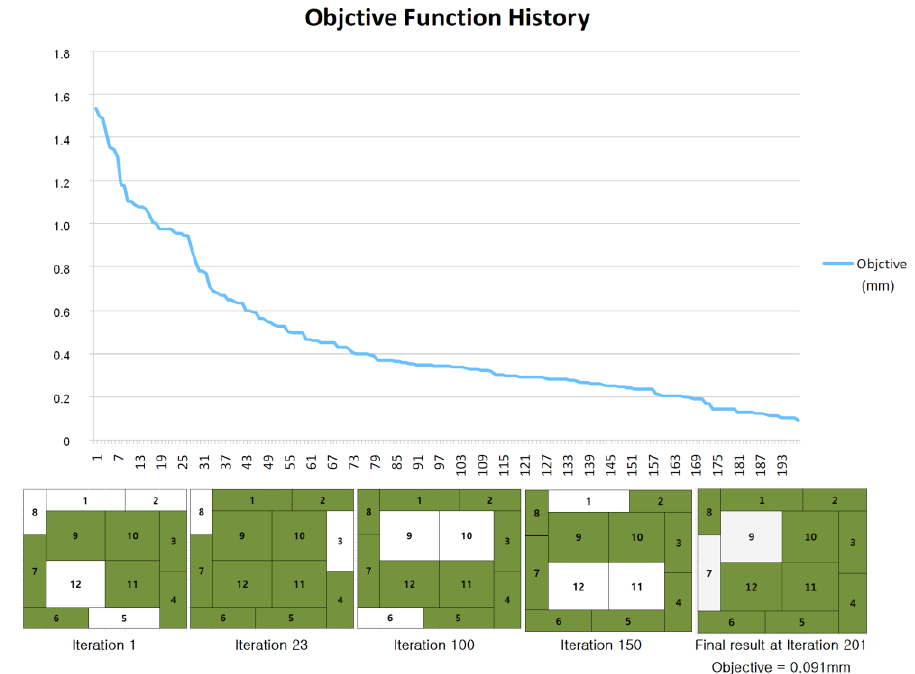
Figure 5. Optimization using the genetic algorithm.